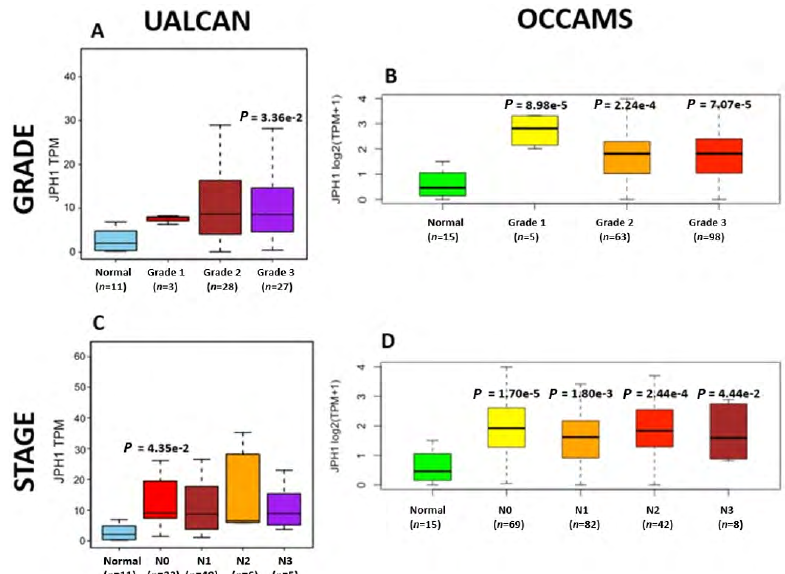
Figure 10. OAC tumor grade and nodal metastatic stage boxplots for JPH1 . Details as described in Figure 7